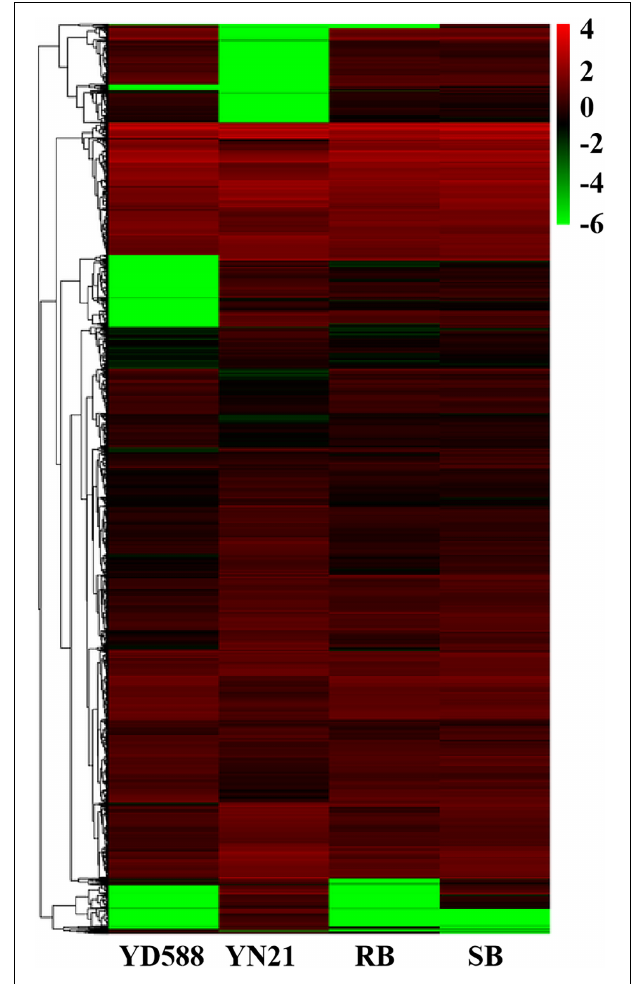
FIGURE 5 | Heat map of the differentially expressed genes (DEGs) between the resistance and susceptible parents YD588 and YN21 and their derived resistance and susceptible bulks from their derived F 2 : 3 families. RB, resistance bulk; SB, susceptible